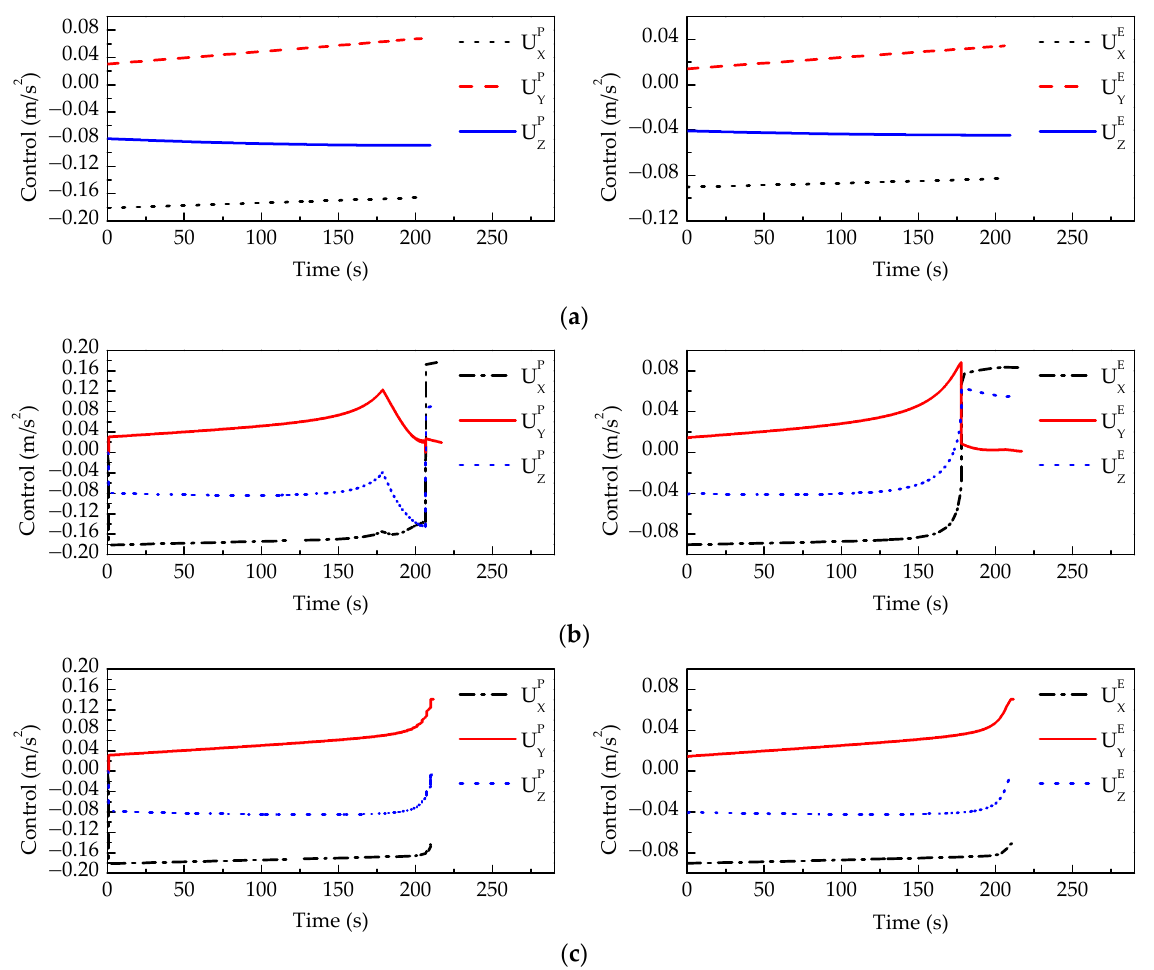
Figure 10. The average control variable of 100 Monte Carlo runs in the scenario that the pursuer plays ( a ) without time delay; ( b ) without compensation for time delay; and ( c ) with compensation for time delay.